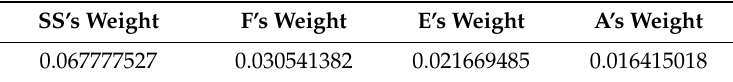
Table 4. Seniority-based ANP weights ( t i ) of the workers.